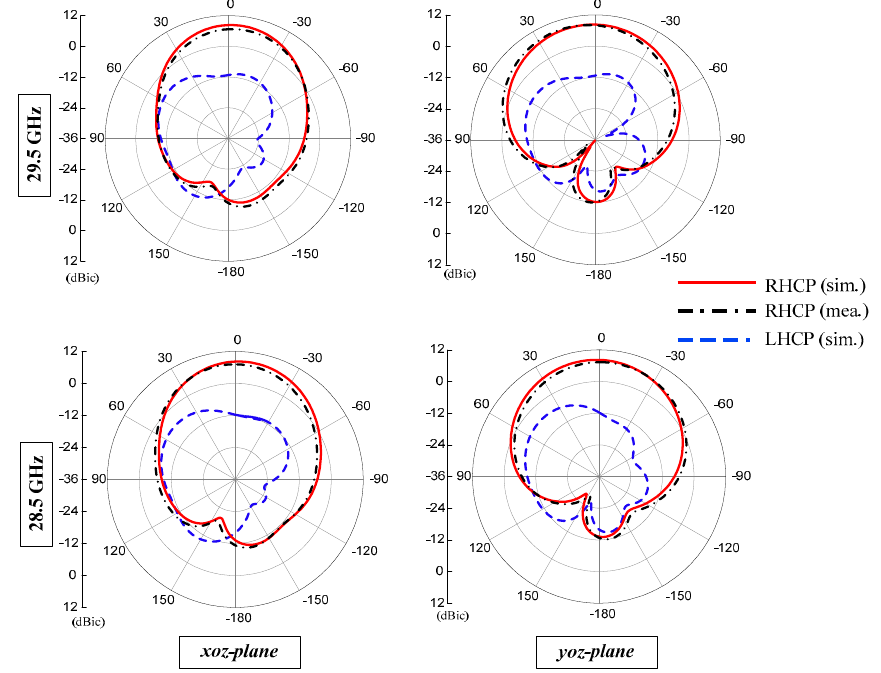
Figure 7. Radiation patterns of the proposed CP ME dipole antenna for different frequencies.